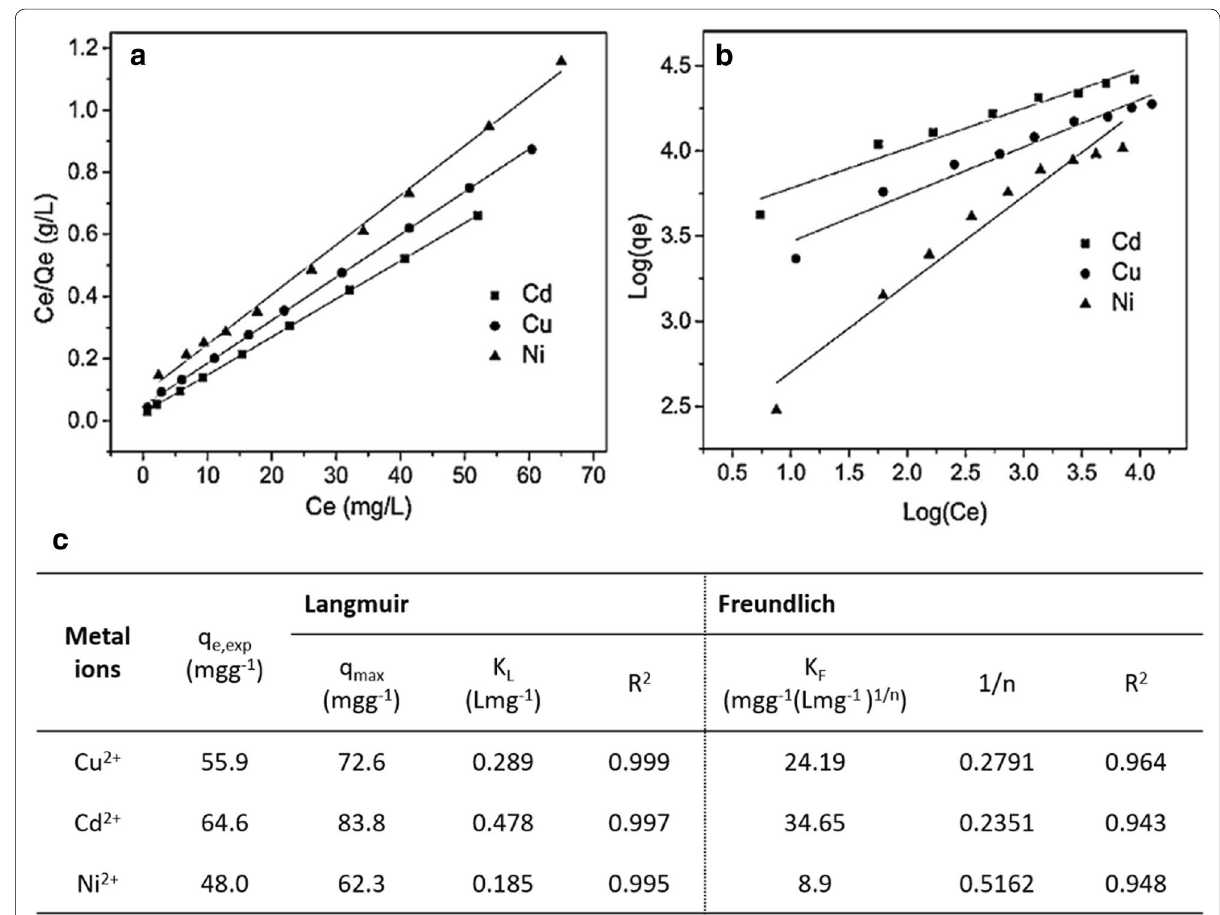
Fig. 3 a Langmuir, b Freundlich isotherms, and c parameters of all models for the Cd 2 + , Cu 2 + , and Ni 2 + ions adsorption on GO membranes. (Reprinted from